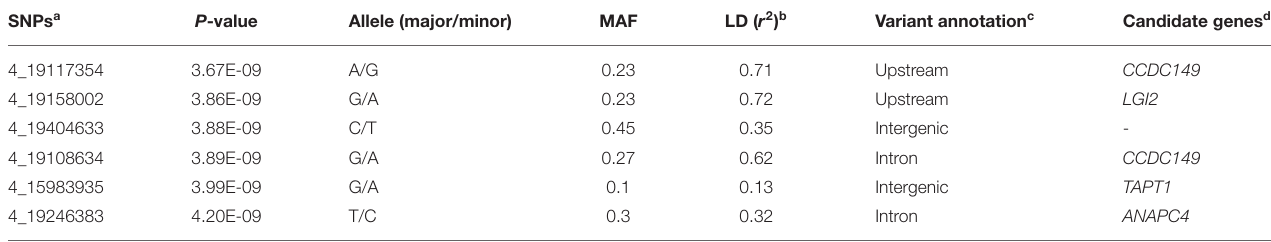
Supplementary Figure S1 | Image of beak of XGG. Supplementary Figure S2 | Q-Q plot of beak length trait. Supplementary Figure S3 | The predicted 3-D structures of SEPSECS corresponding to a substitution of glutamine (A) to lysine (B) at position 420. Supplementary Figure S4 | Haplotype block analysis of all significant SNPs for beak length trait. Supplementary Table S1 | Summary of all detected significant SNP loci that associated with beak length trait. The red backgroud showed the SNPs above the genome-wide